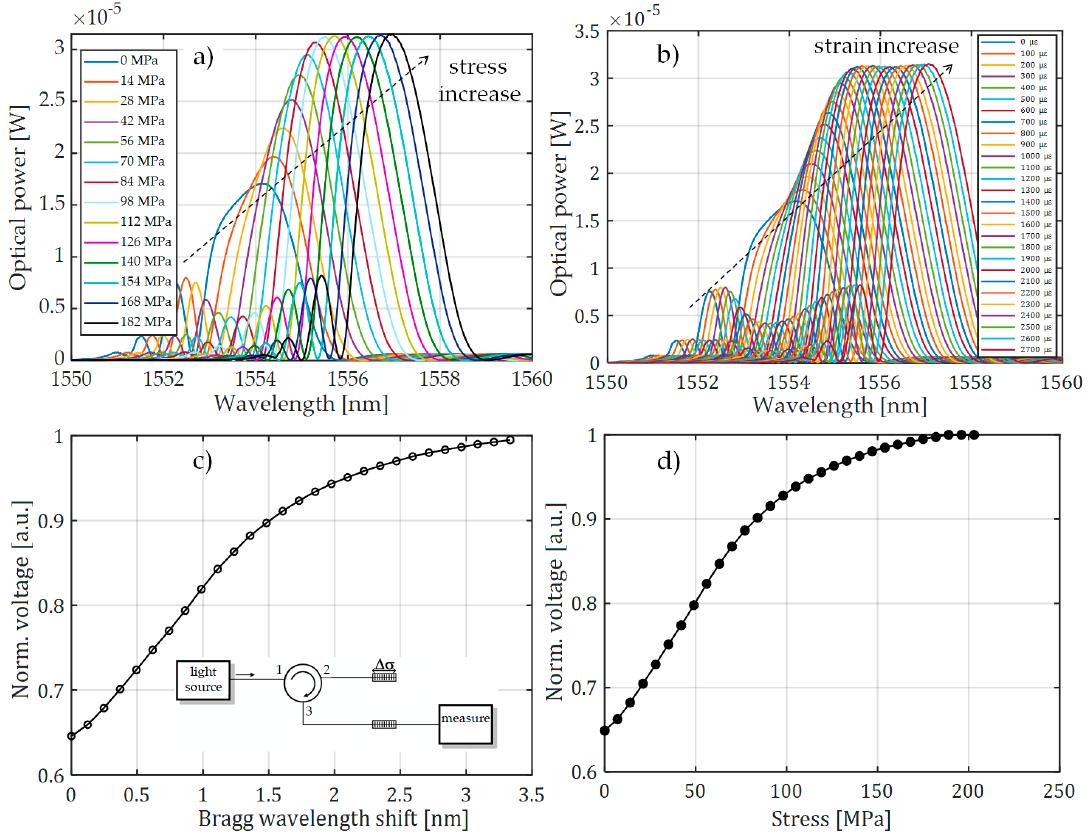
Figure 8. The measurement results obtained from the interrogation stand (as in Figure 3b) for the matched grating pair FBG + FBG1: ( a ) spectral response change for an increase of tension; ( b ) spectral response change for an increase of strain; ( c ) the transient characteristic of wavelength shift to DC voltage generated by the photodetector; ( d ) characteristics of the power line wire tension conversion to a change of photodetector voltage.